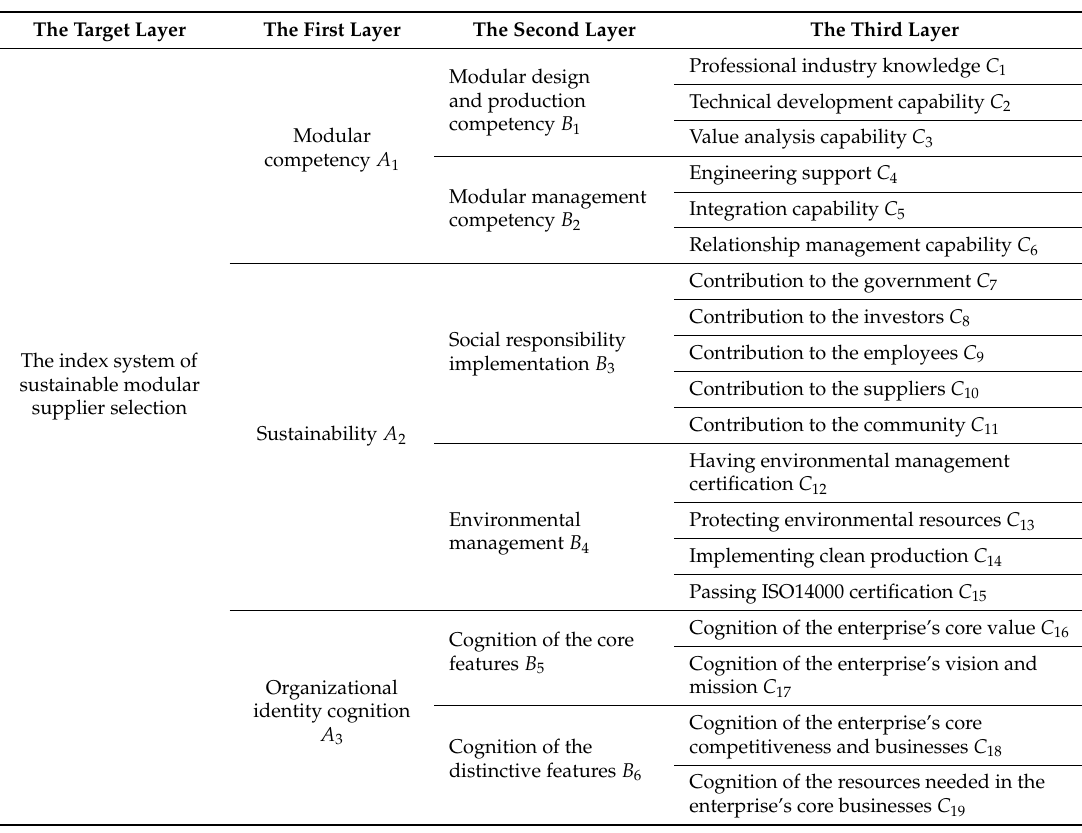
Table 8. Hierarchical structure of the index system of modular supplier selection.